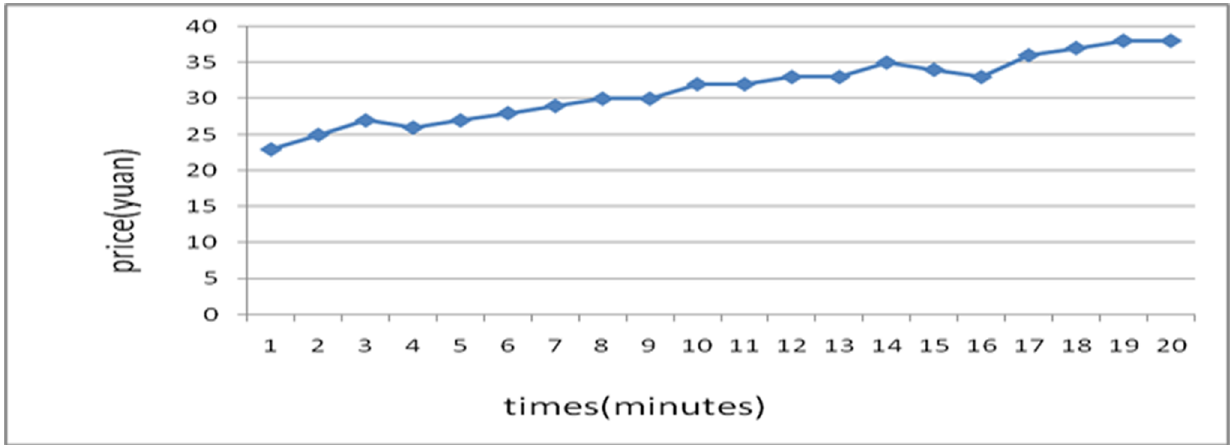
Figure 8. Experiment of a Unilaterally Price-Falling Situation with Manipulation.